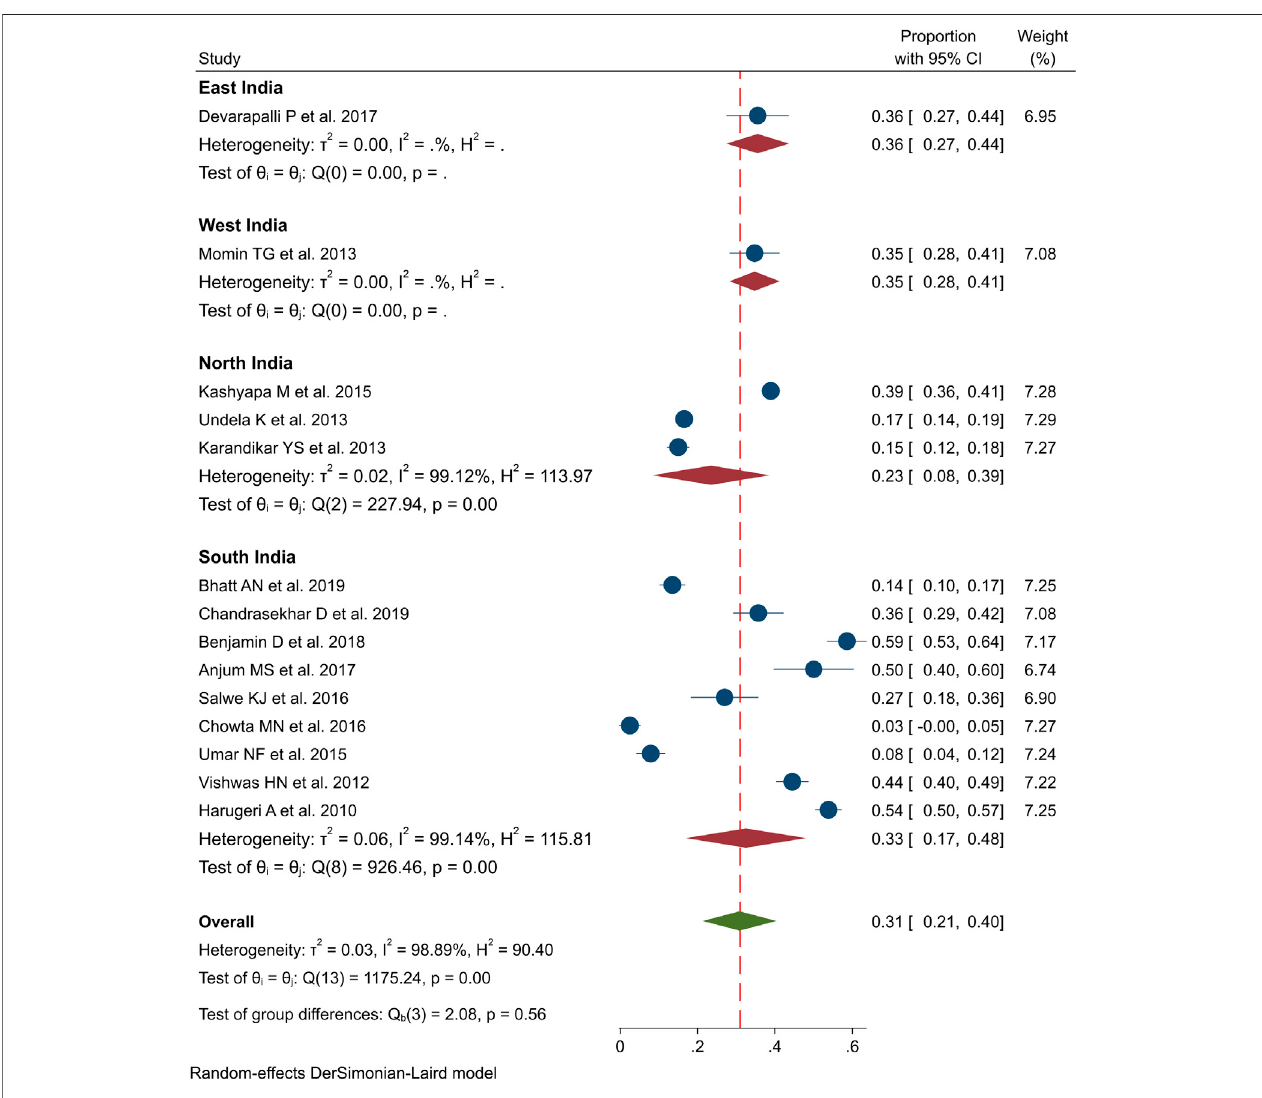
FIGURE 3 | Prevalence of hyperpolypharmacy ( ≥ 10 drugs) use in older people across various geographic regions in India.